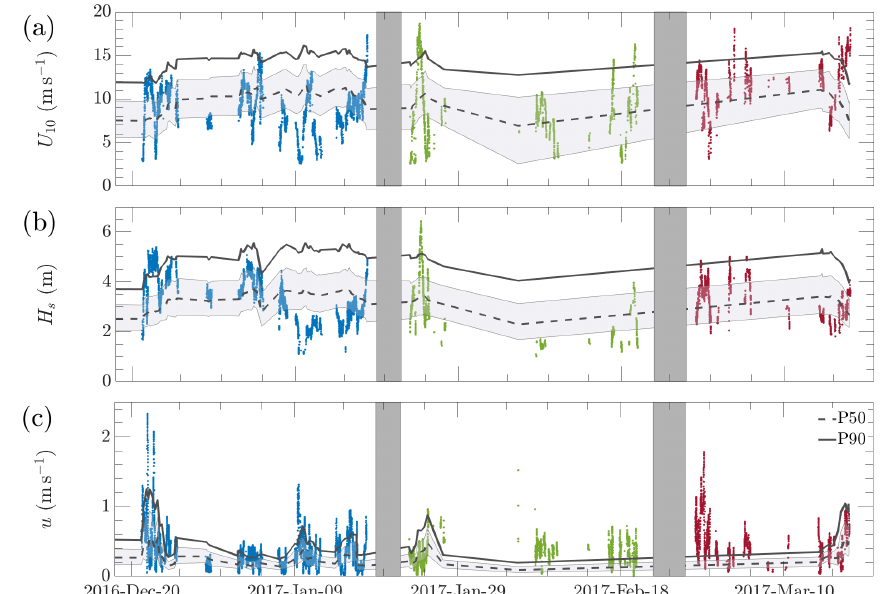
Figure 6. Time series of sea state variables in Leg 1 (blue), Leg 2 (green), and Leg 3 (red): (a) wind speed from the automated weather station, (b) significant wave height, and (c) current speed. For each variable, the dashed line and shading represent the 50th percentile and its interquartile range IQR, respectively, based on climate statistics from satellite observations; the solid line indicates the 90th percentile.